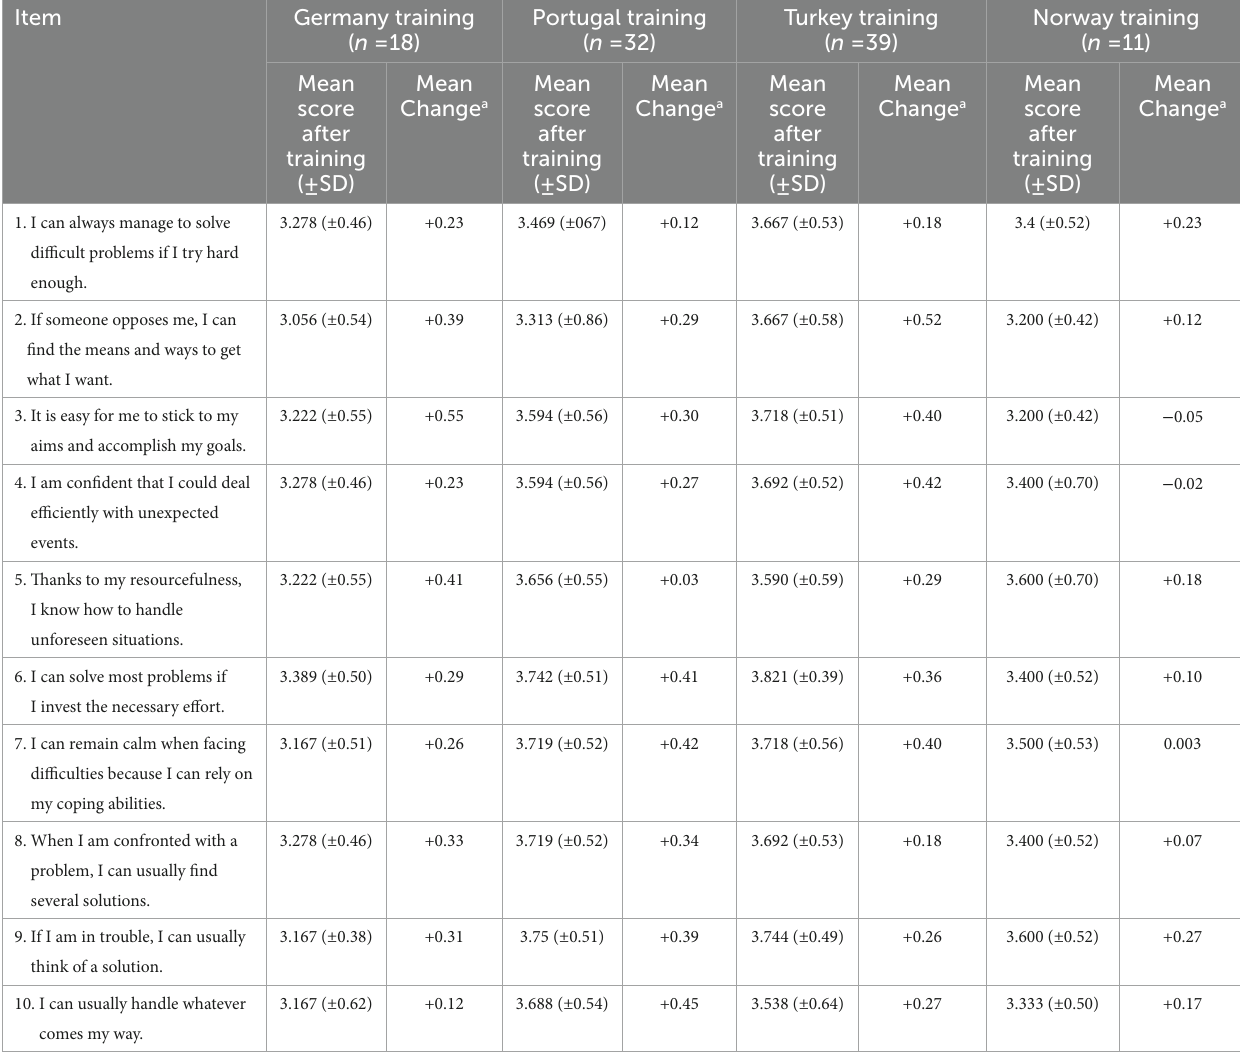
TABLE 4 Comparison of means, and their change per item of the Self-efficacy scale between countries ( N =